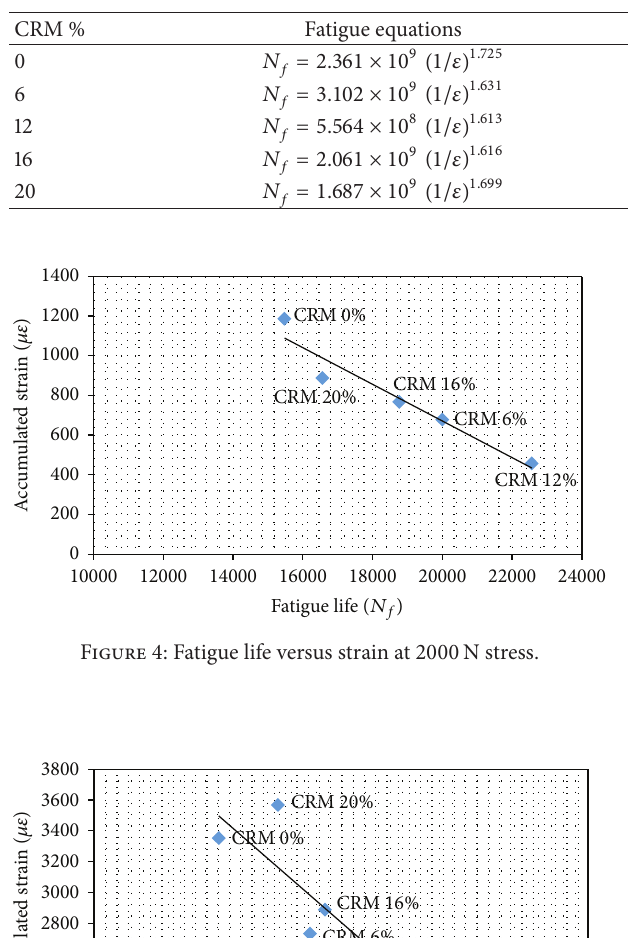
crumb rubber and the respective correlation coefficients are presented as well. It is observed that deviation from the optimum CRM content decreases the fatigue life of reinforced asphalt samples. The CRM asphalt deters tensile and vertical cracks from being effortlessly formed by horizontal tensile stresses and stops them from propagating [2–26].